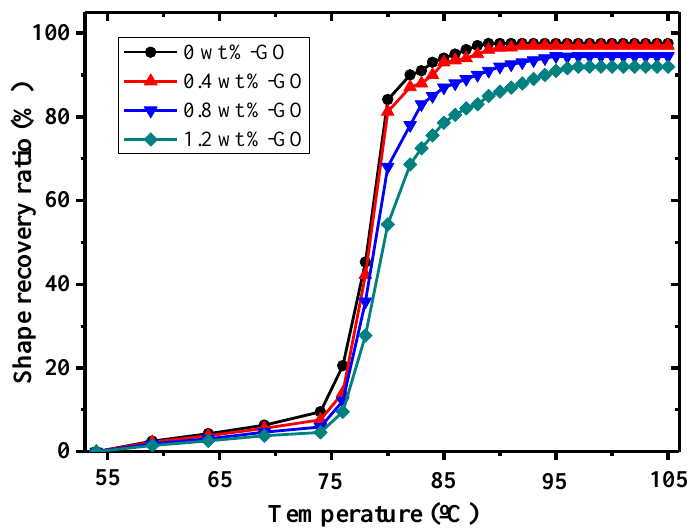
Figure 13. Process for the test of shape memory properties.